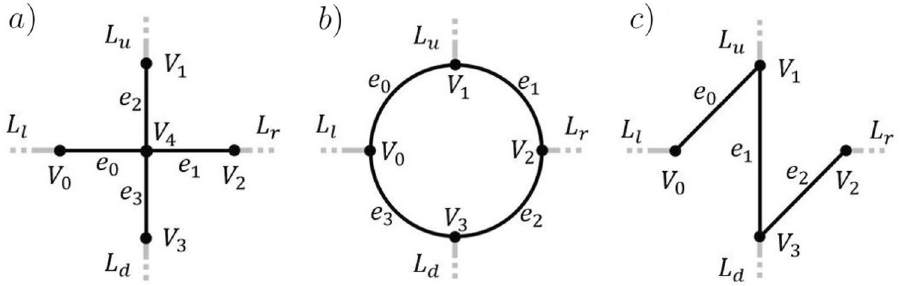
Figure 1. Three examples of open quantum graphs are shown. ( a ) Represents a cross resonator, ( b ) a ring resonator and ( c ) some zig zag structured resonator. The edges between vertices are depicted in black and open leads in